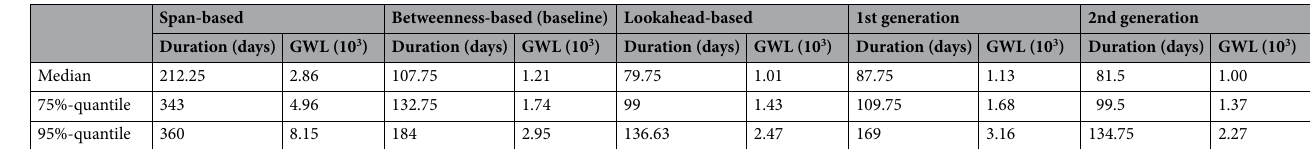
Figure 2. Time-varying, median number of unrestored bridges throughout the rapid response campaign, under different guiding strategies proposed. This plot tracks the median behaviour of the repair agent of severely- and moderately-damaged bridges, respectively, pursuant to 1000 simulations run. By doing so, their overall performance can be benchmarked against each other, and therefore highlighted. ( a ) The proportion of severely- damaged bridges, remaining to receive rapid response delivered by Agent A following each strategy. ( b ) The proportion of moderately-damaged bridges, remaining to be fully repaired by Agent B , with respect to each of the strategy adopted by Agent A .